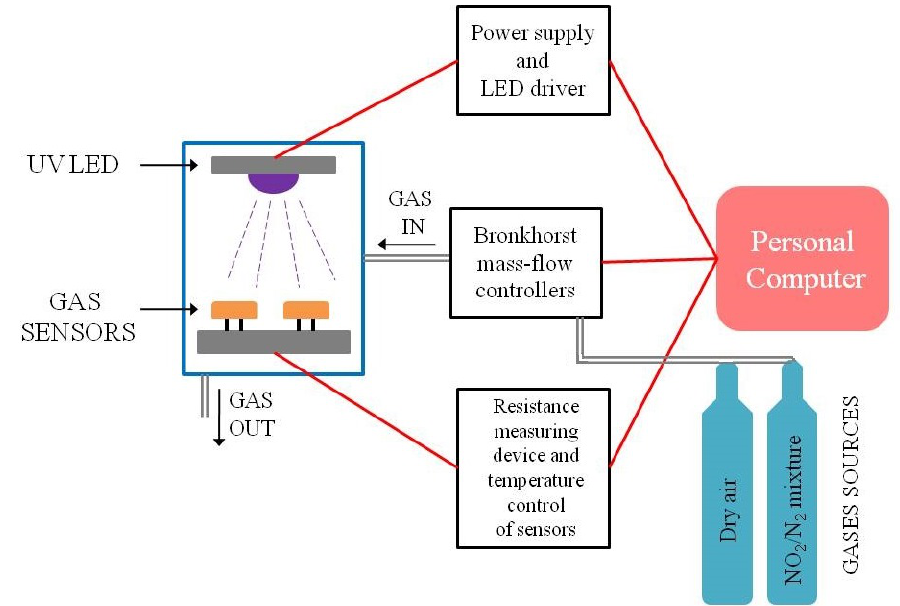
Figure 2. Block representation of the setup for sensor